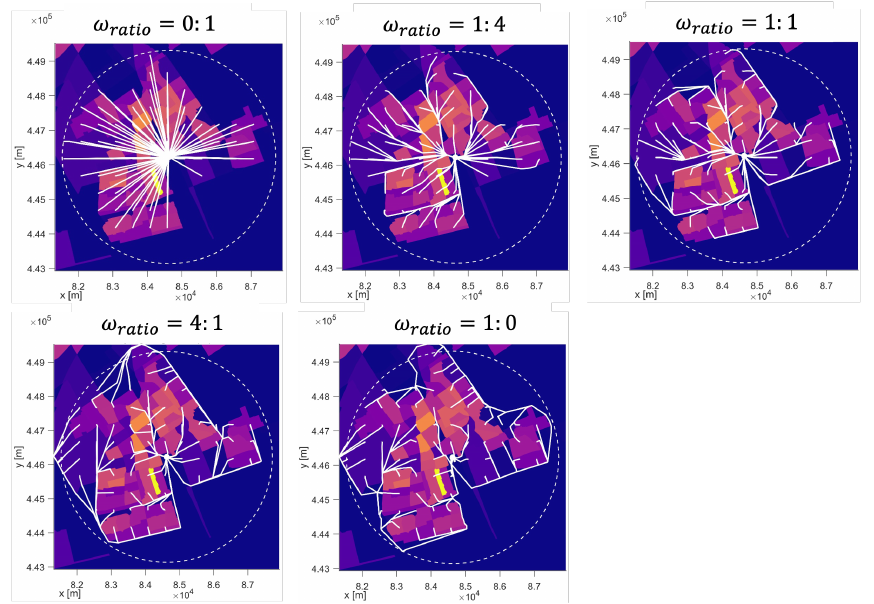
Figure 5. Generated paths with different risk weight ratios.